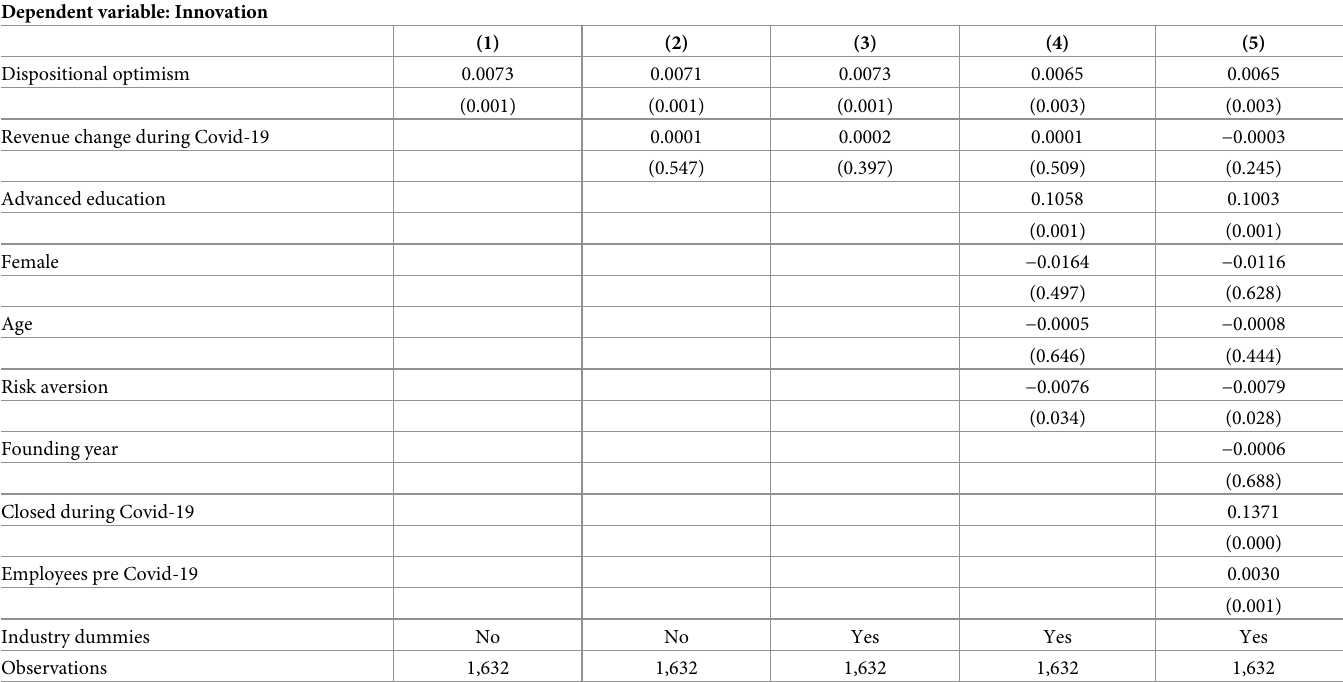
Table 3. Optimism and innovation during the Covid-19